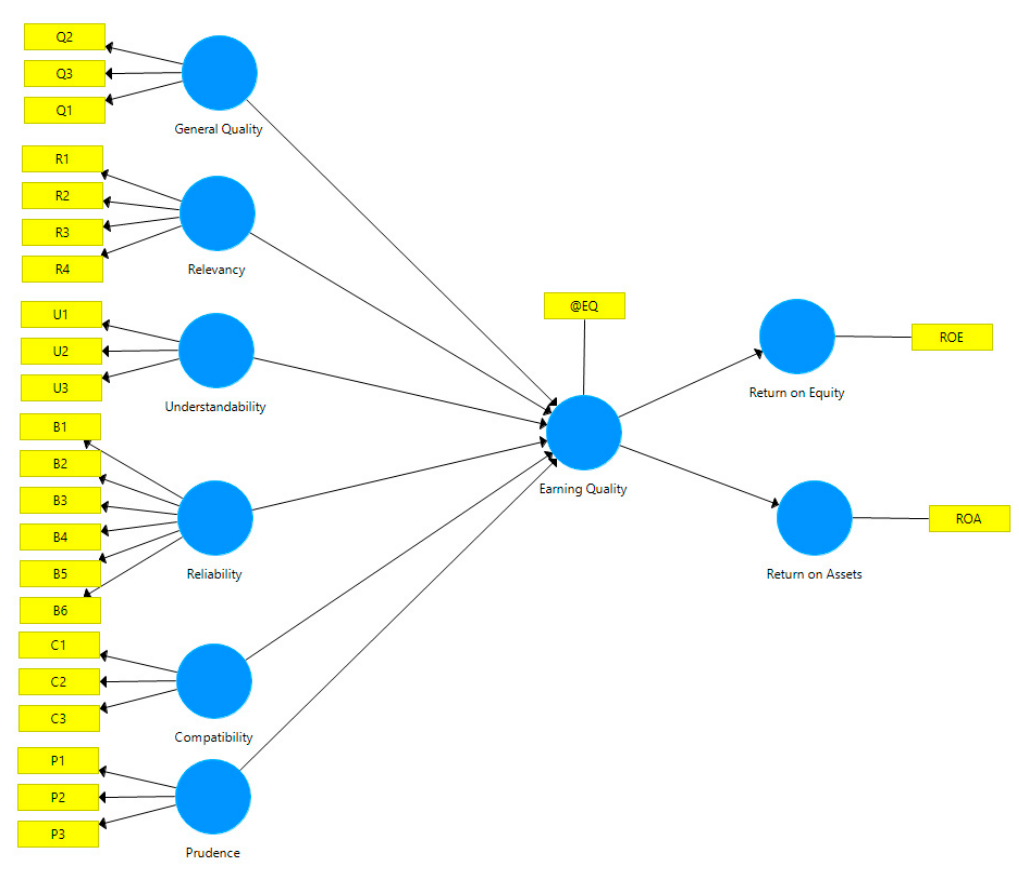
Figure 1. Research Model. Source: Developed by the author using the Neural Network System.